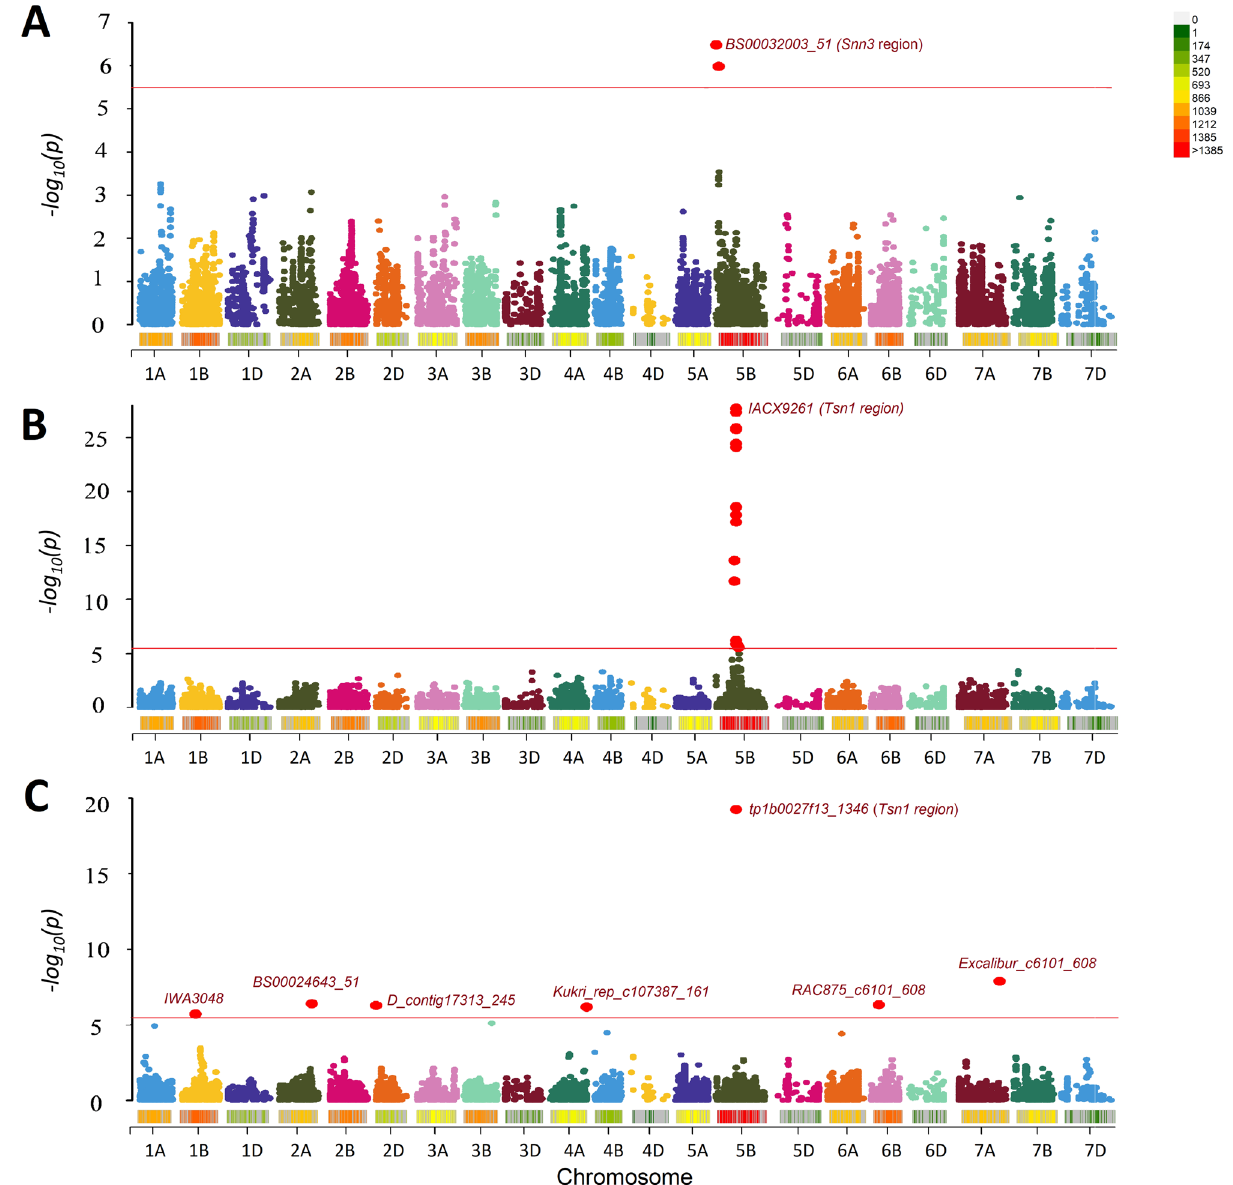
Figure 2. A Manhattan plot representing the marker-trait associations (MTAs) identified for SNB response and NEs reactions. (A) The MTAs for SnTox3 infiltrations, (B) MTAs for SnToxA infiltrations; (C) and MTAs for SNB response. The color scale indicates SNP density on the bar given in the inset. The red line depicts the Bonferroni corrected threshold for identifying significant associations. The significant associations are represented with red